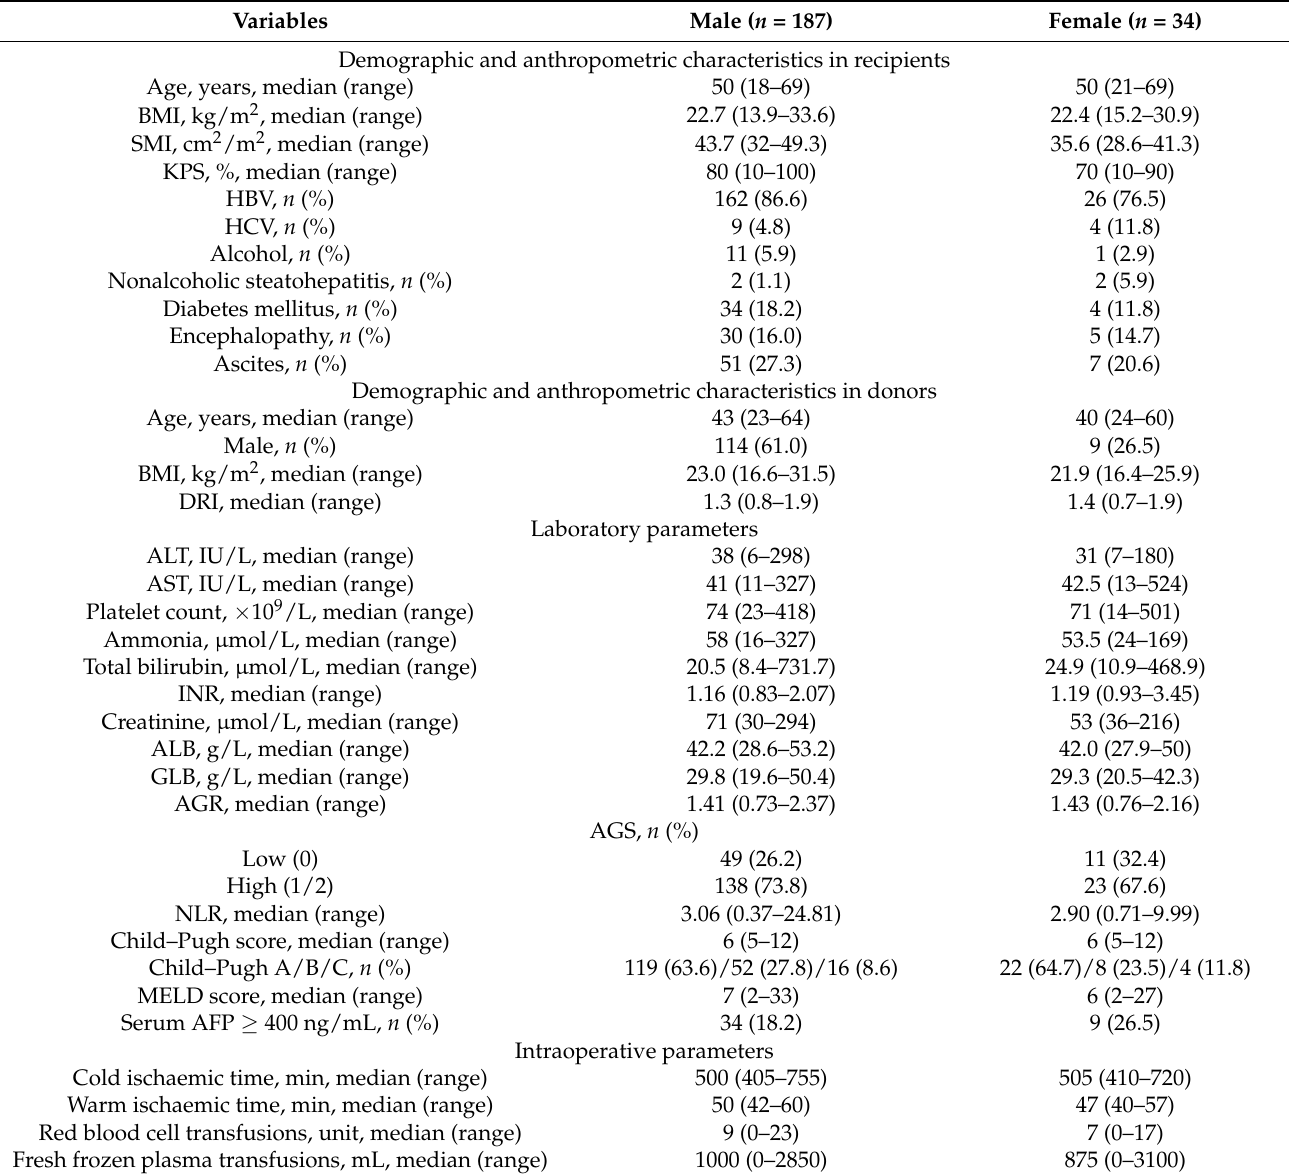
Table 1. Characteristics of included HCC patients who underwent DDLT for male and